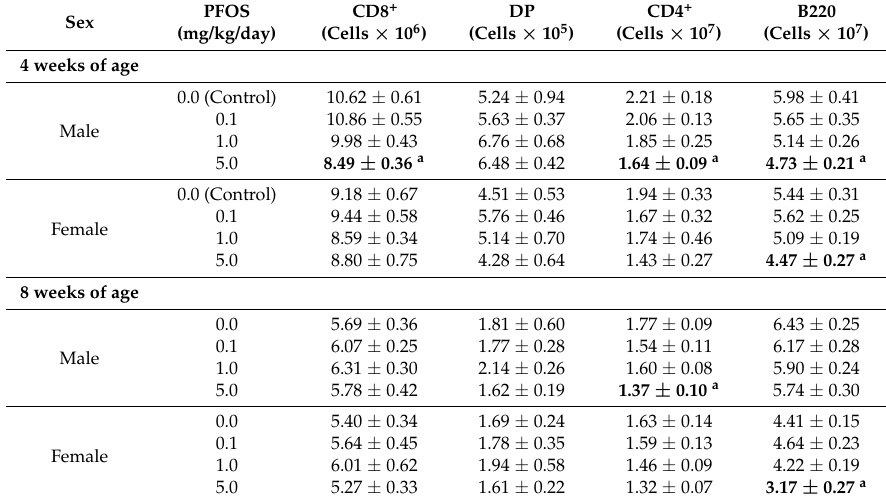
Table 2. Splenic lymphocyte sub-populations in C57BL6 mice exposed in utero to PFOS during GD